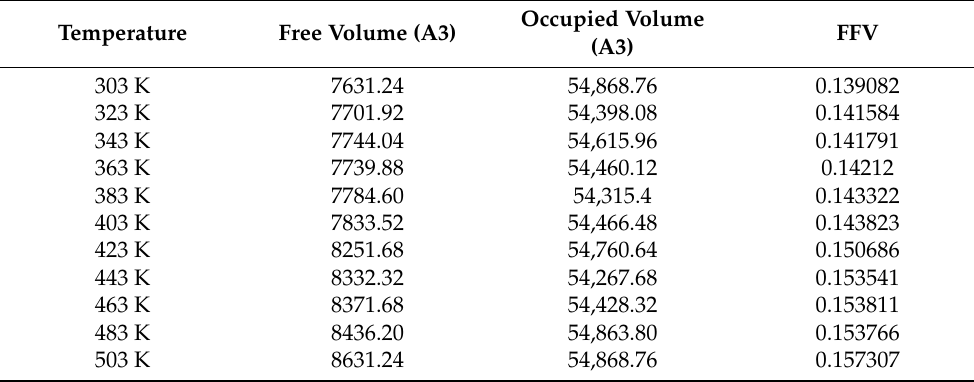
Table 1. Free volume of the unmodified nano-SiO 2 and cellulose composite